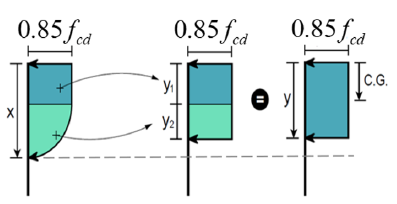
Figure 5. Representation of calculation